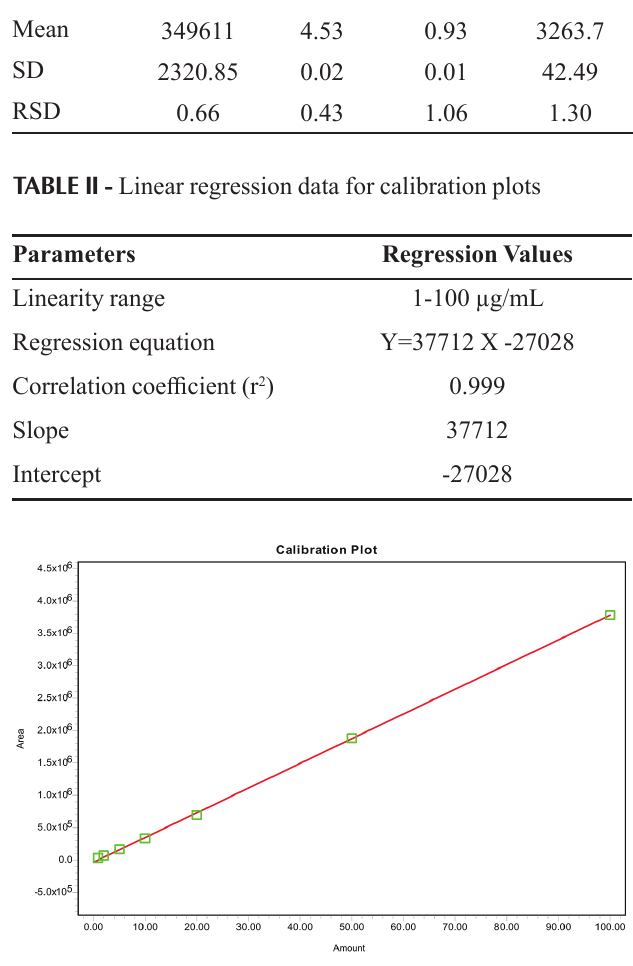
FIGURE 2 - Calibration plot of epirubicin hydrochloride (concentration range 1‑100 μg/mL). TABLE III - Intra‑day and inter‑day precision (n=6) Theoretical